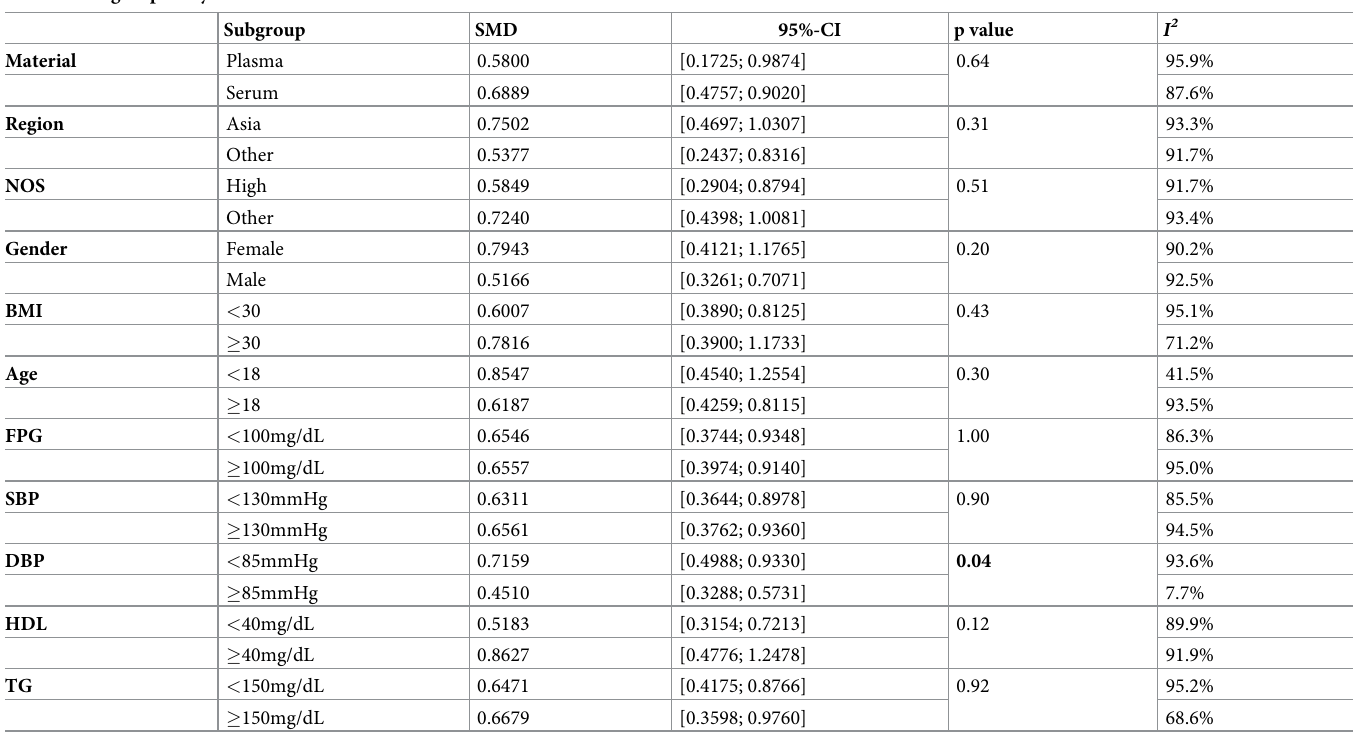
Table 3. Subgroup analysis of the studies for the fetuin-A and